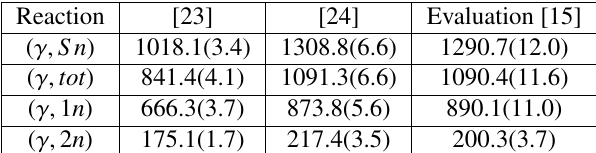
Figure 4. The comparison of the evaluated ([15], circles) and the experimental ([23], triangles and [24], squares) 75 As cross /σ int for 75 As sections: (a) σ ( γ, 1 n ), (b) σ ( γ, 2 n exp e v al